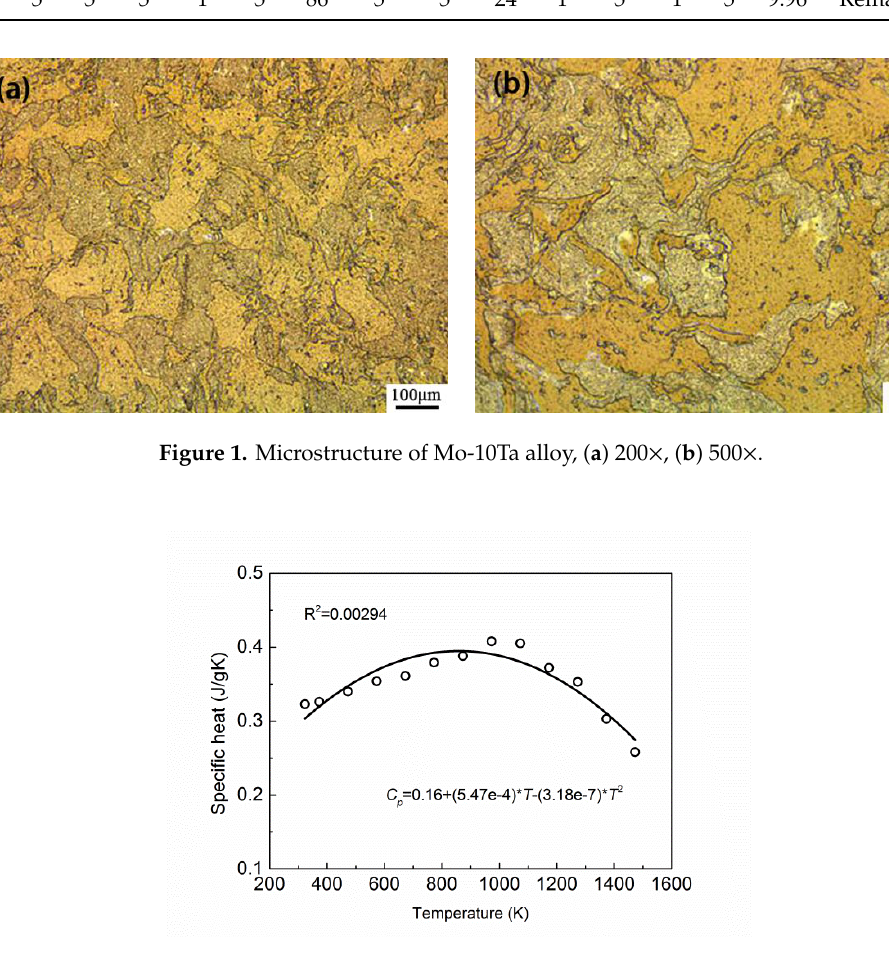
Figure 2. The relationship between specific heat ( C P ) of Mo-10Ta and temperature ( T ).